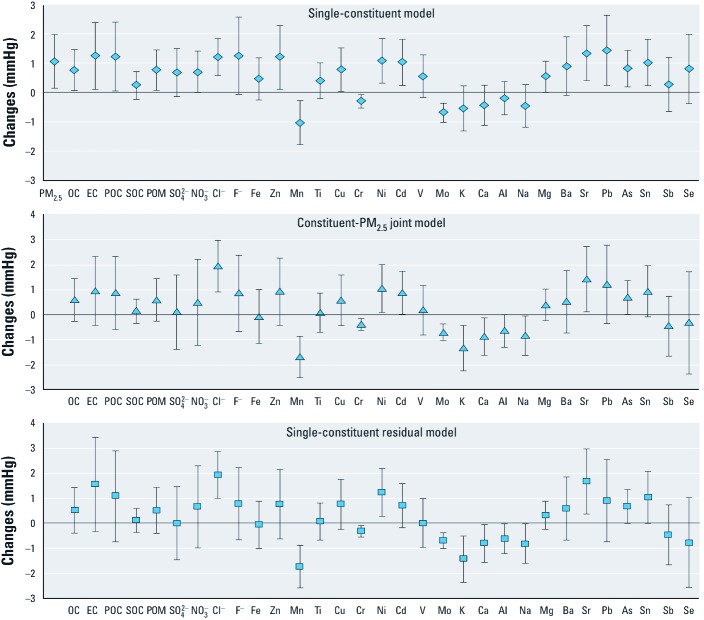
Changes in SBP associated with IQR increases in PM2.5 constituents at concentration during the preceding day before the BP measurement. Estimates are adjusted for age, BMI, season, month, day-of-study, squared day-of-study, day-of-week, hour-of-day, study site, temperature, and relative humidity in linear and quadratic terms. Data are presented as effect estimates ± 95% CIs. For constituent-PM2.5 joint models, we used the main effect estimates of PM2.5 constituents for result presentation.